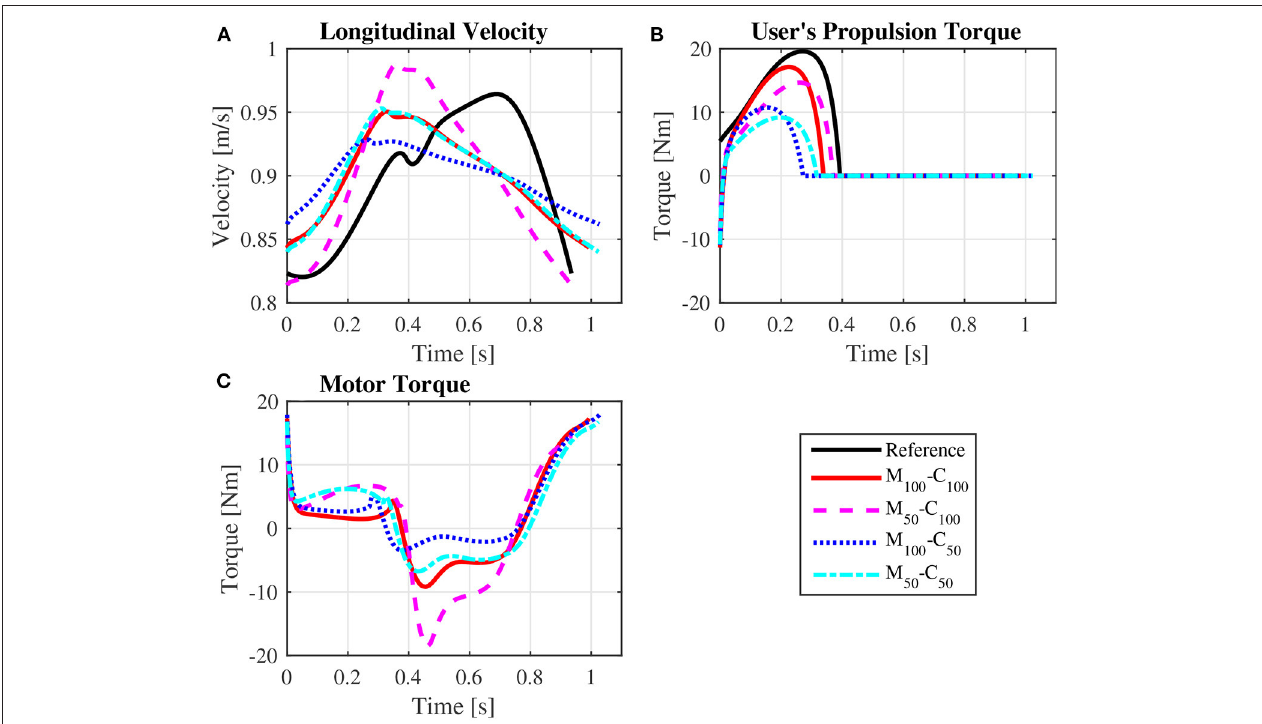
FIGURE 4 | Predicted wheelchair speed profile (A) , bilateral propulsion torque applied by the user (B) , and bilateral torque applied by the motors on the rear wheels of the wheelchair (C) for steady state locomotion on a level surface at an average speed of 0.9 m/s for the reference unassisted condition (Reference), and for